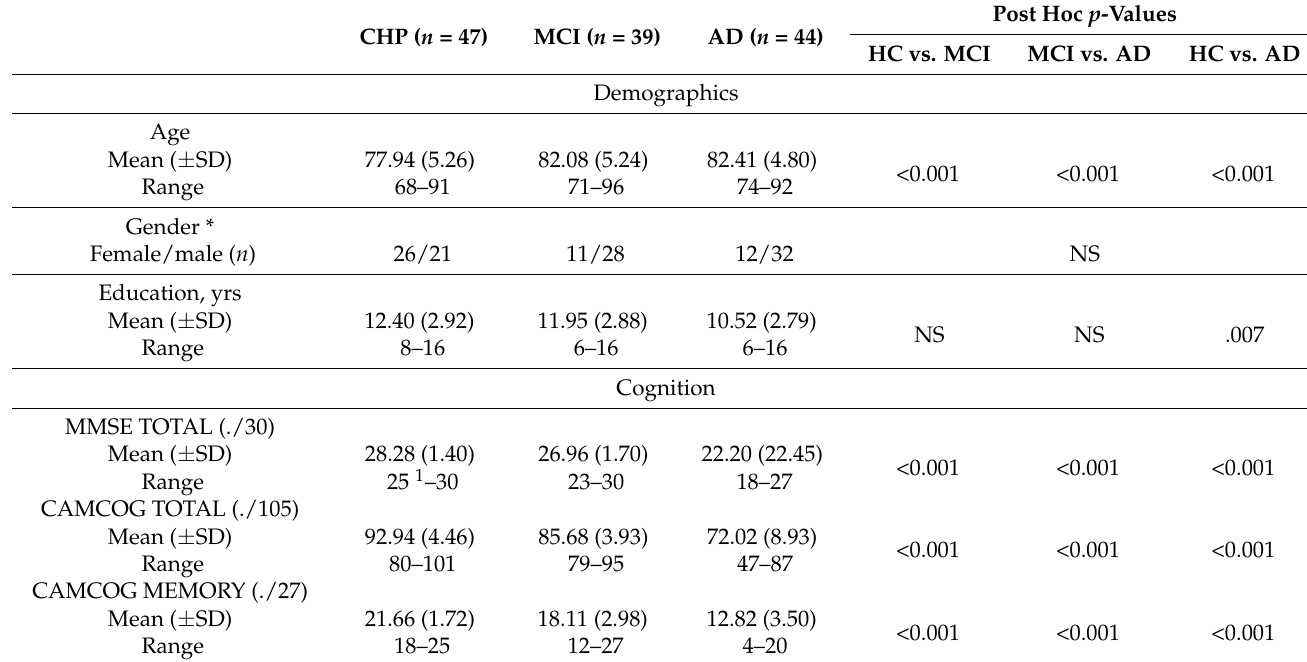
Table 1. Demographic characteristics, cognitive functioning measured with MMSE and CAMCOG, daily functioning measured with the